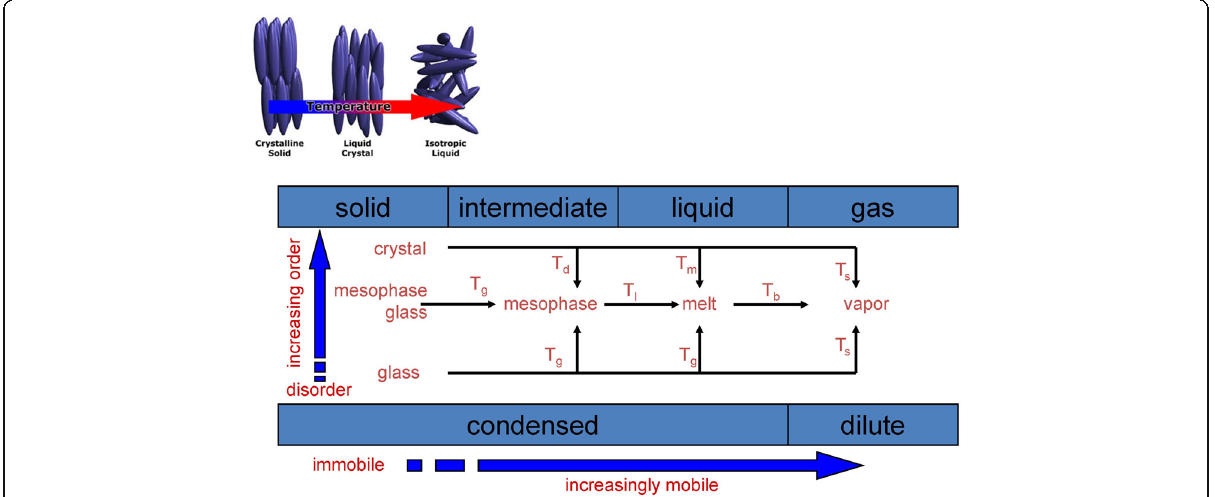
Fig. 10 Schematics of the transitions between ordered and disordered solid systems in a one-component system (adapted from Wunderlich